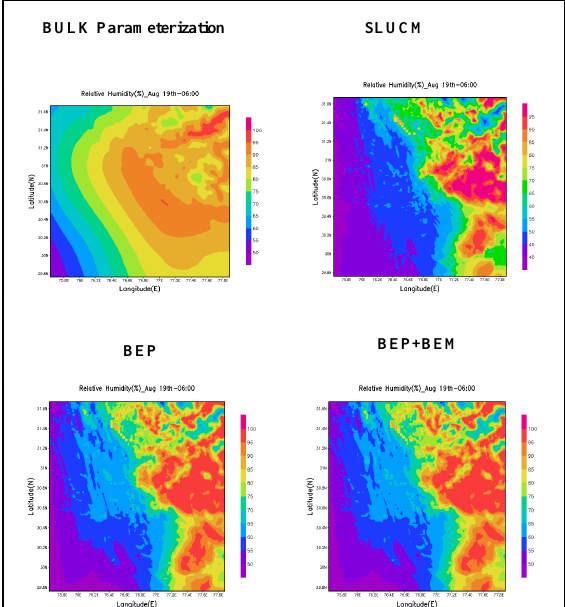
Figure 4. Spatial distribution of Relative Humidity with four Urban physics schemes over d02 on August 19 th 11:30 IST